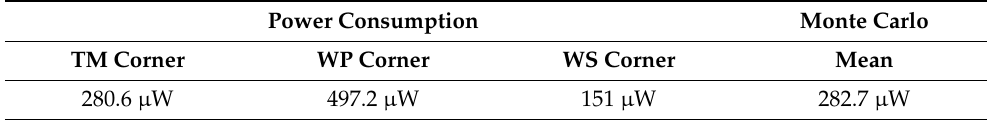
Table 15. Behavior of power consumption in corner